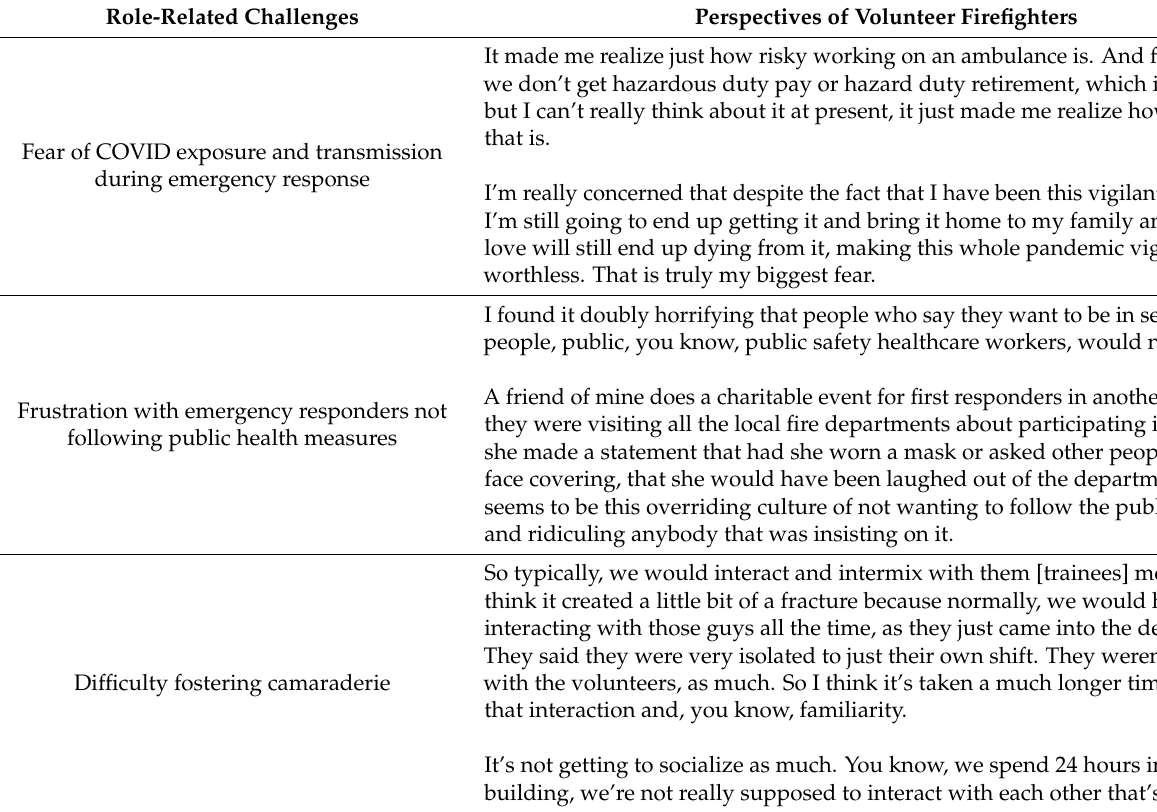
Table 2. Stumbling Blocks for Volunteer Firefighters during the COVID-19